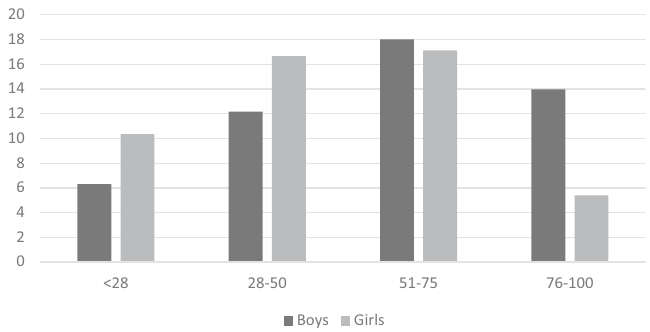
Figure 1. Adolescents grouped according WHO5 scores. Participants with scores of under 28 were at risk of clinical depression, while those with scores of over 75 displayed high levels of well-being.